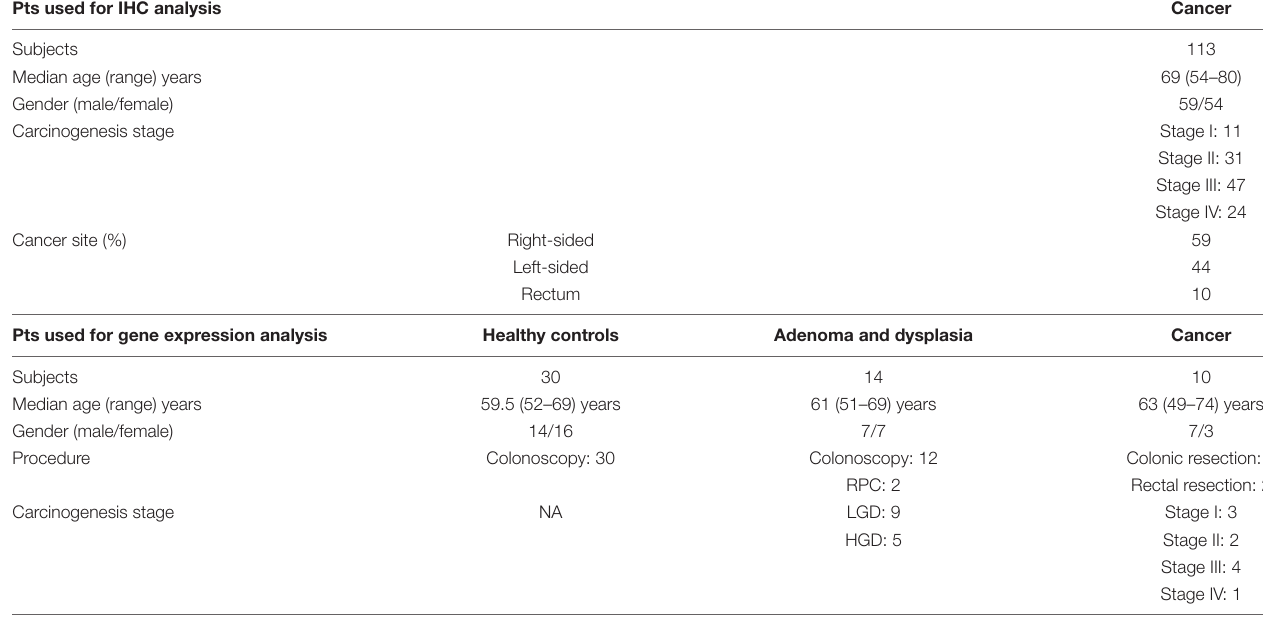
TABLE 1 | Patients